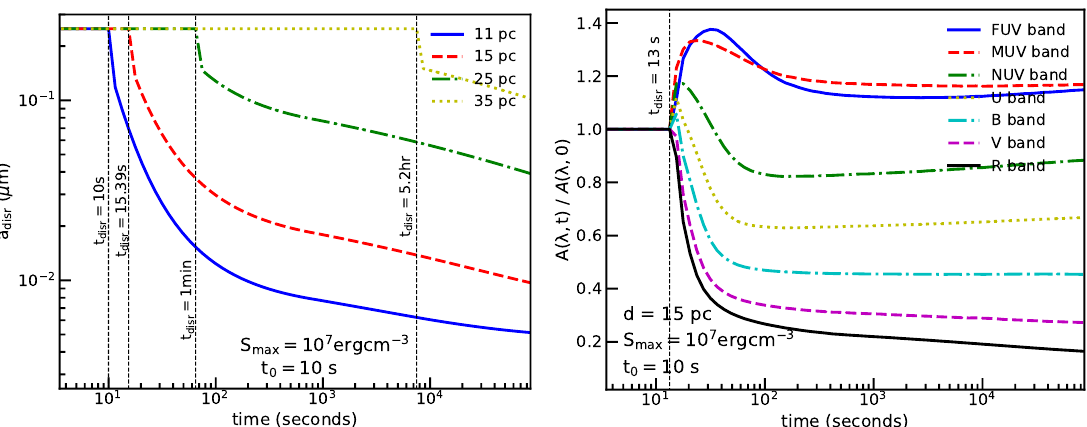
Figure 22. Left panel: Variation of grain disruption size by RATD with time for the different cloud distance, assuming S max = 10 7 ergcm − 3 . RATD occurs earlier (see vertical lines) and a disr can achieve smaller values for smaller t 0 . Right panel: Variation of the extinction in the different bands with time. From Hoang et al. [124].